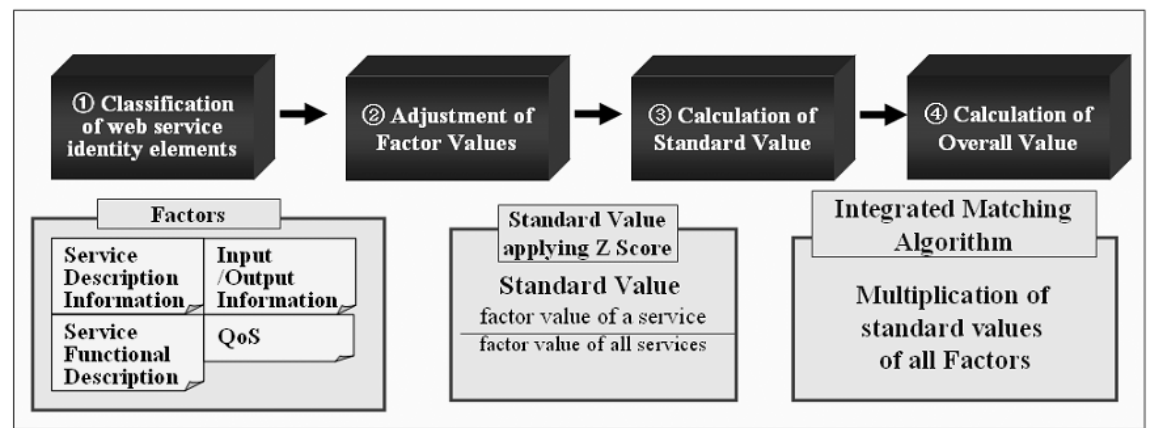
Figure 1. Integrated Matching Algorithm Process.